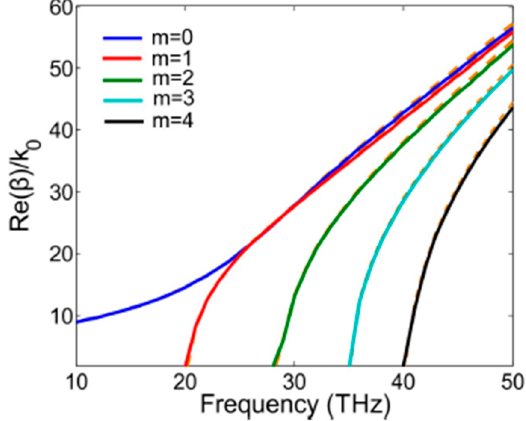
Figure 2. Theoretical (dotted lines) and simulation (solid lines) results for the dispersion relations of GSPs modes in the GNW.